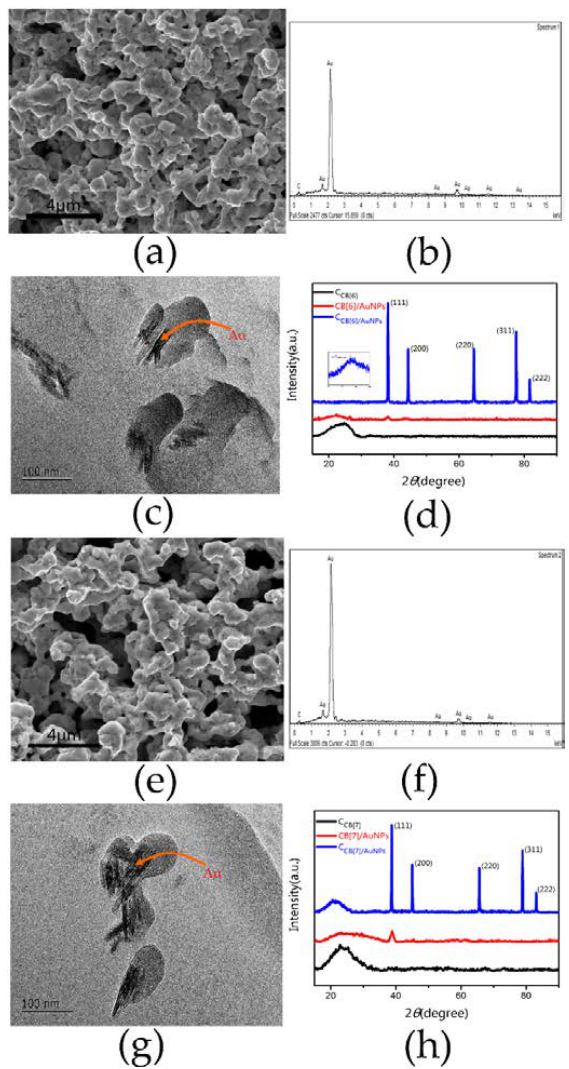
Figure 2. ( a ) Secondary electron SEM image of C CB[6]/AuNPs ; ( b ) EDS pattern of C CB[6]/AuNPs ; ( c ) TEM image of C CB[6]/AuNPs ; ( d ) XRD pattern of CB[6] and corresponding materials; ( e ) Secondary electron SEM image of C CB[7]/AuNPs ; ( f ) EDS pattern of C CB[7]/AuNPs ; ( g ) TEM image of C CB[7]/AuNPs ; ( h ) XRD pattern of CB[7] and corresponding materials.